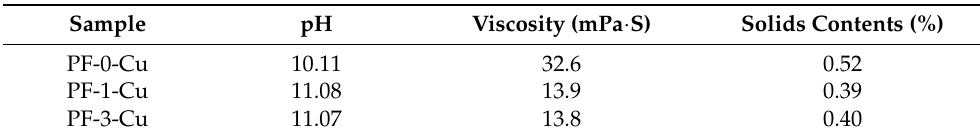
Table 2. Viscosity, solids content and pH values of PF resin, alone or amended with nano-copper